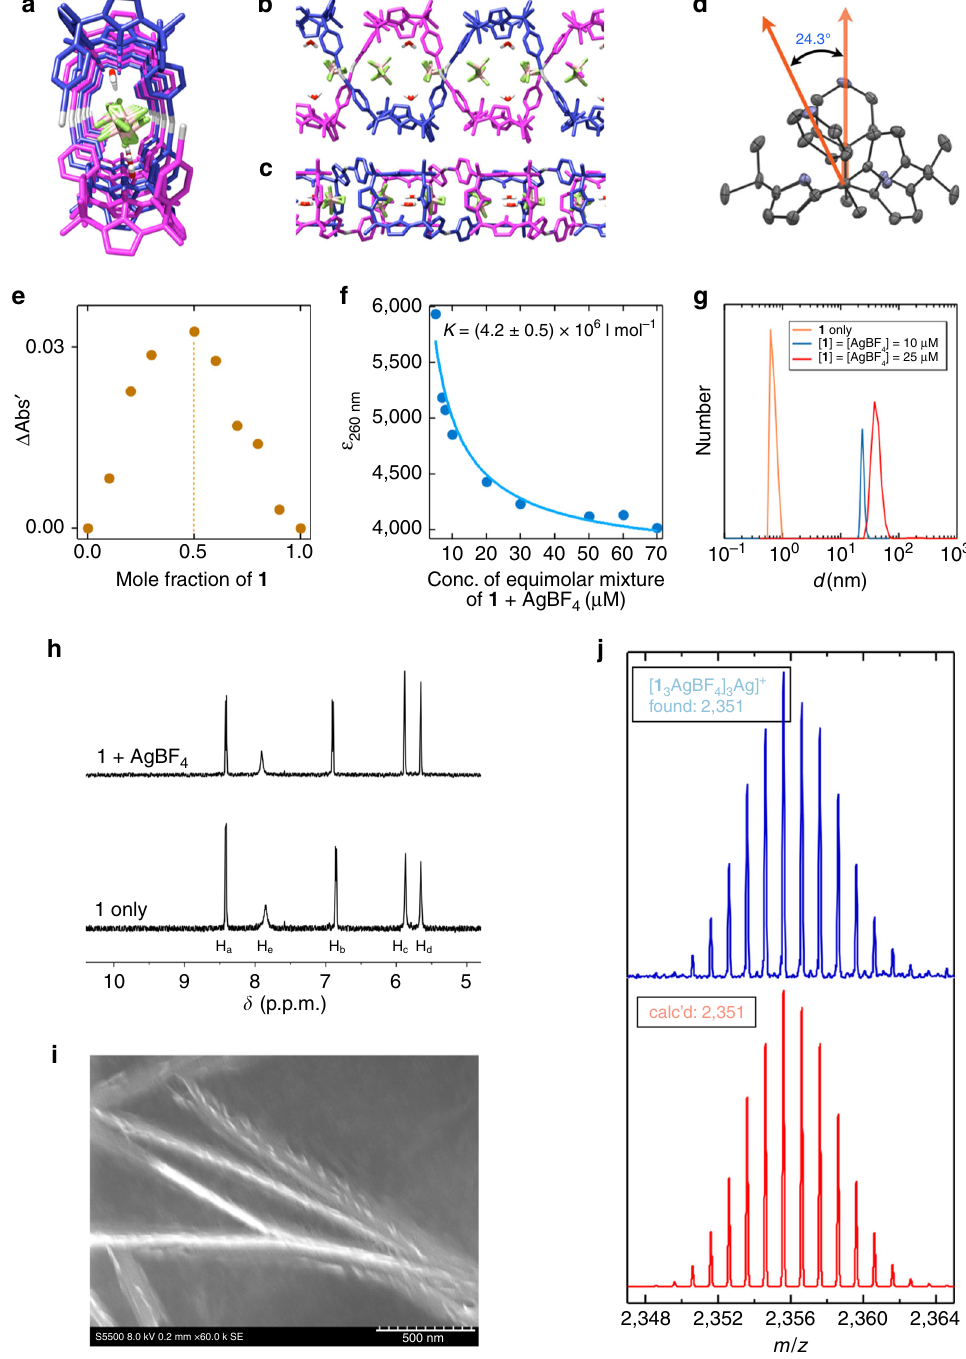
Fig. 2 Studies of the Ag(I)-linked double-stranded helical complex. a – c Single-crystal X-ray structure of double helix comprised of 1 , AgBF 4 , and a water molecule viewed from the front a , the side b , and the top c . d Partial structure illustrating the torsional angle between the two pyridine subunits (protons are omitted for clarity). e Job-plot analysis of the components, 1 and AgBF 4 , which combine to produce a helix with net 1 : 1 binding stoichiometry. f Binding isotherm analysis corresponding to the formation of a double-stranded complex from Ag(I) and 1 . g Size comparison between 1 and the helix derived from it, as inferred from dynamic light scattering experiments. h Expanded 1 H NMR spectra highlighting the minimal spectral changes induced when 1 is exposed to Ag(I). i Scanning electron microscopic image of the helix. The scale bar denotes 0.5 μ m. j Cold spray ionization (CSI) – MS spectrum of the mixture of 1